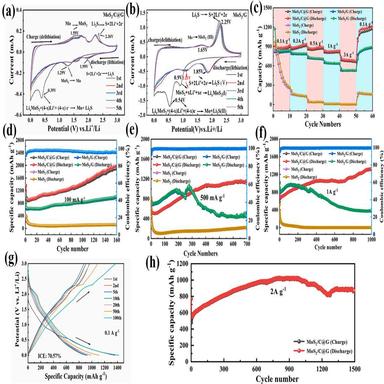
(a-b) CV curves of MoS2/C@G and MoS2/G; (c) Rate capacities at different current density, (d) Cycling performance at 100 mA g− 1 , (e) Cycling performance at 500 mA g− 1 , (f) Cycling performance at 1 A g− 1 ; (g) Charge-discharge curves, (h) Long-cycle stability at 2 A g− 1 of MoS2/C@G.